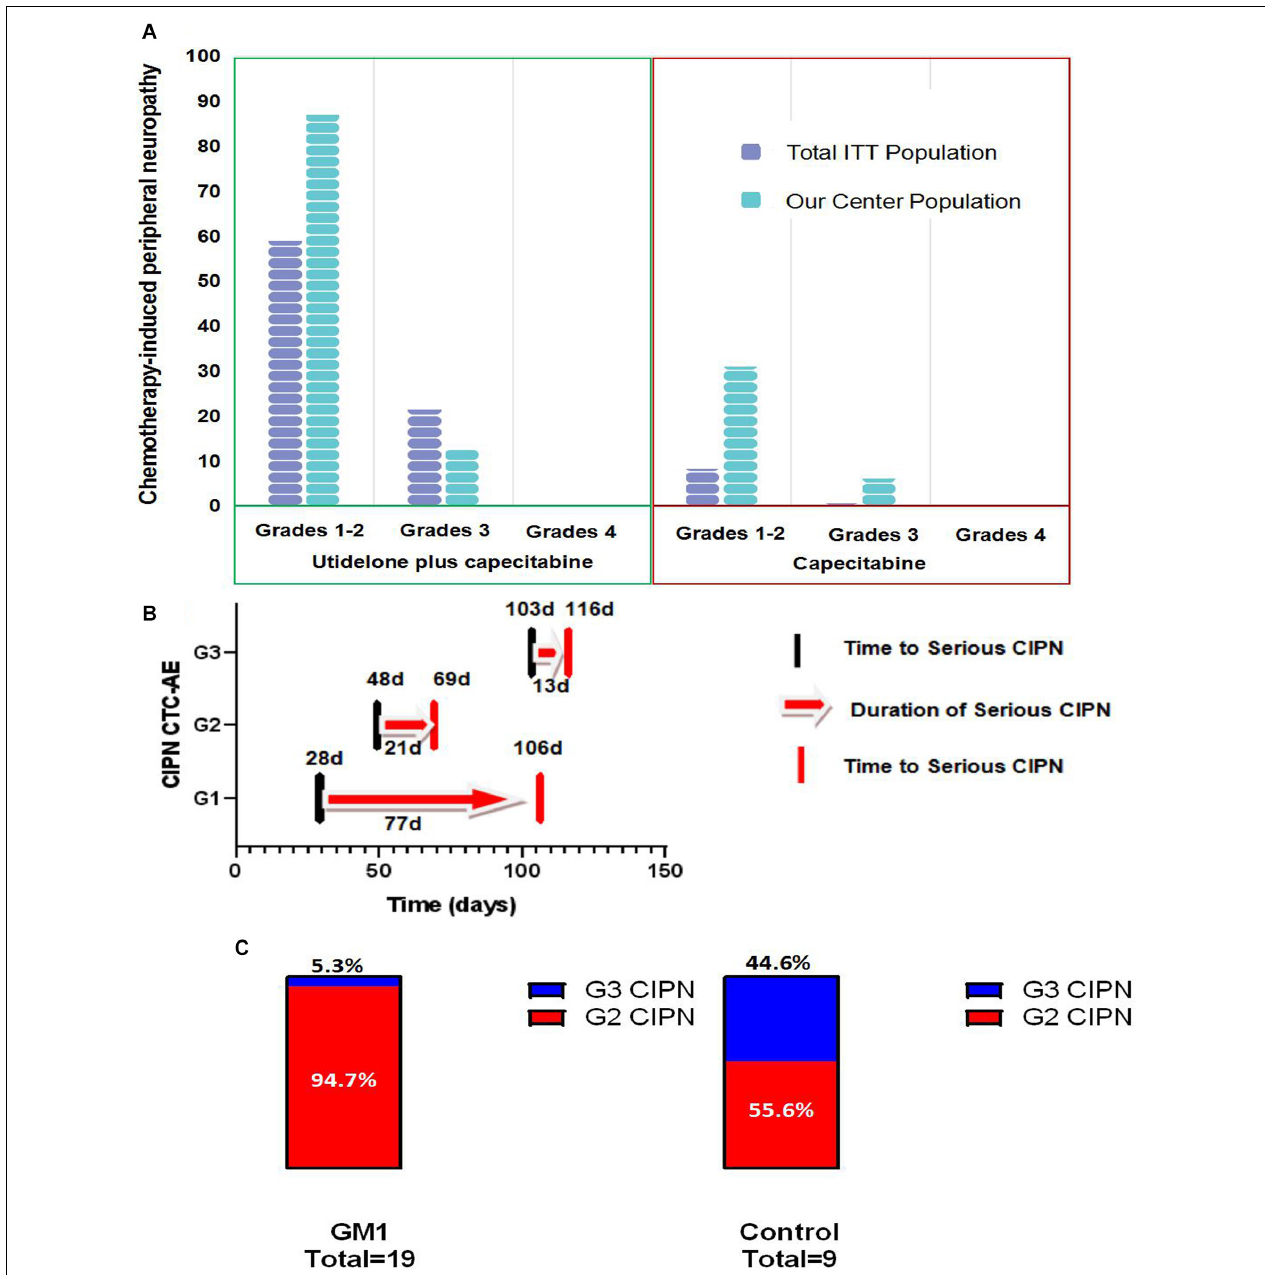
FIGURE 3 | Bar chart of patient-reported chemotherapy-induced peripheral neuropathy in total population and our center population (A) , the time of appearance, remission and duration of serious CIPN (B) bar chart of patient-reported grade 2 and grade 3 of CIPN in GM1 and control groups (C) .